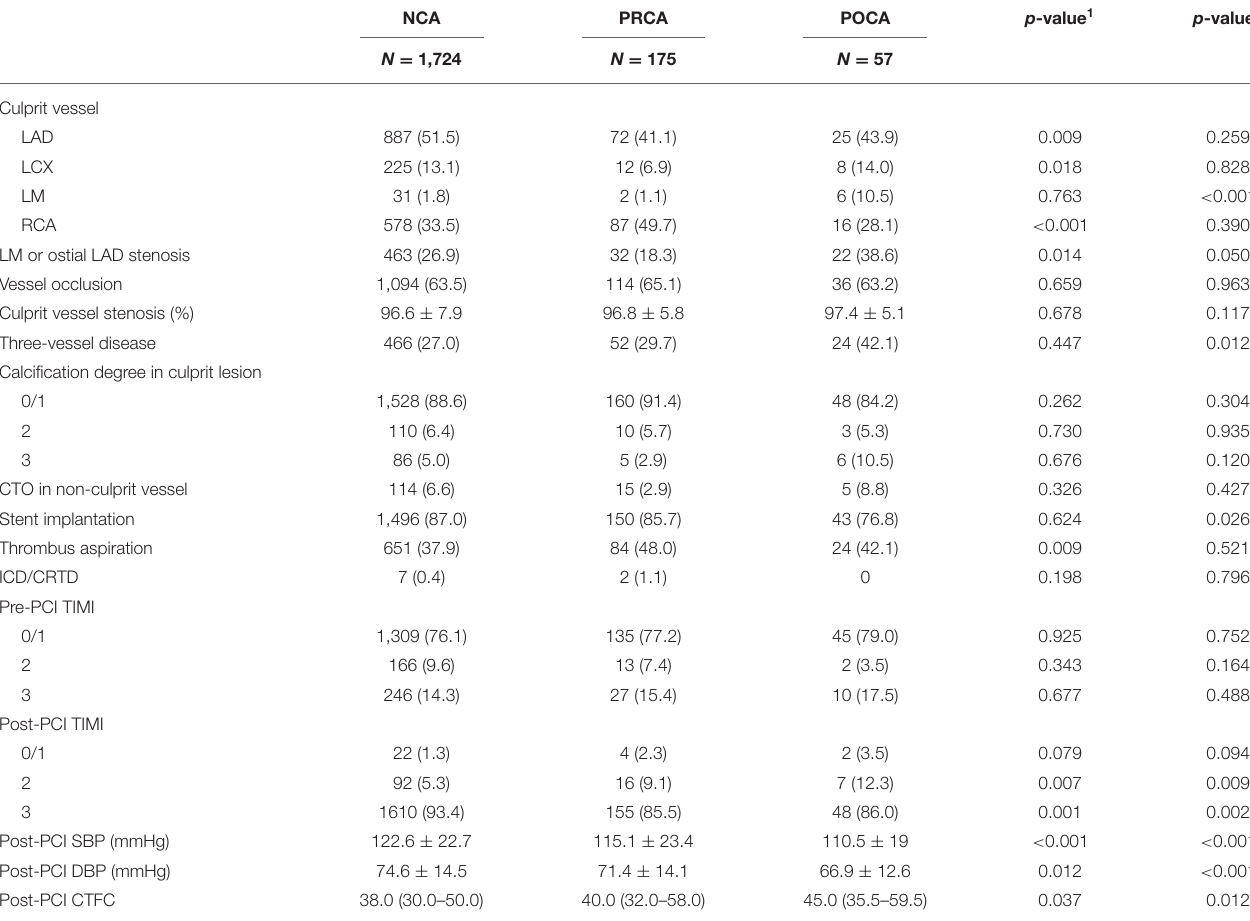
TABLE 2 | Procedural